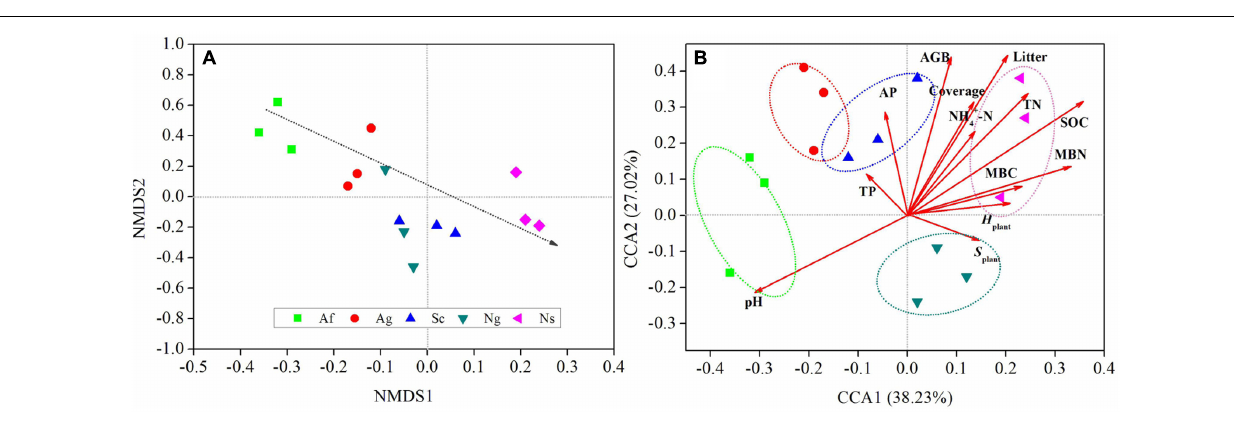
FIGURE 3 | Non-metric multidimensional scaling plot (NMS) based on the calculated Bray-Curtis distance (A) . The distance between symbols is inversely proportional to the degree of similarity between the communities. Canonical correspondence analysis (CCA) of fungal diversity with plant and soil properties (B) . pH, soil pH value; SOC, soil organic carbon; TN,: soil total nitrogen; TP, soil total phosphorus; AP, soil available phosphorus; NH 4 + -N, soil NH 4 -N; MBC, soil microbial biomass C; MBN, soil microbial biomass N; AGB, aboveground biomass; H plant , Shannon-Wiener index; S plant , Patrick